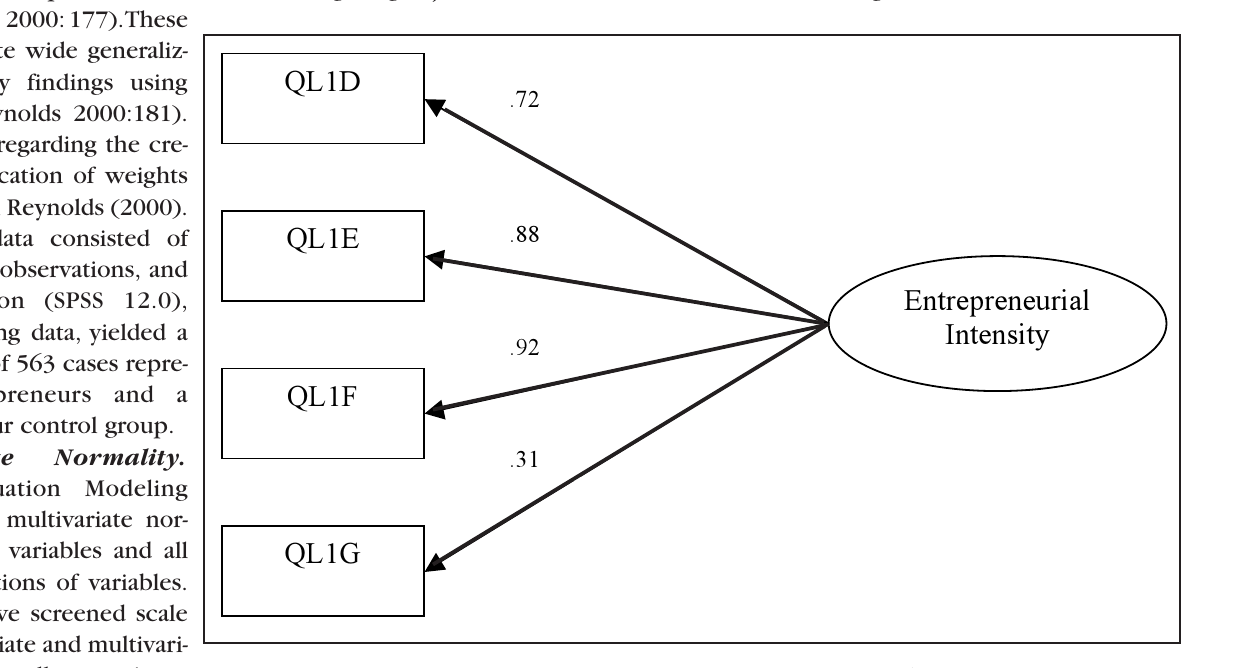
Figure 1. Confirmatory Factor